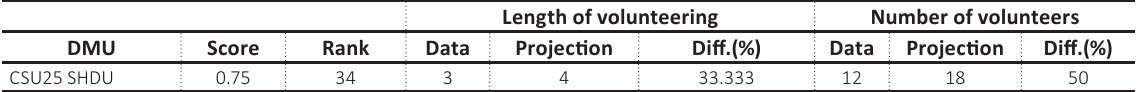
Source: Authors’ calculations.